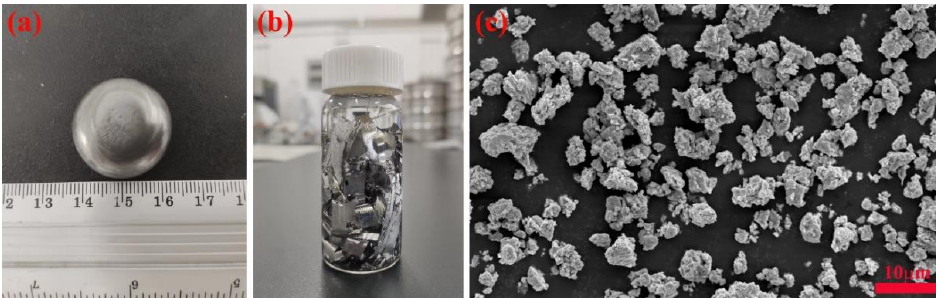
Figure 1. ( a ) Particle size distribution and ( b ) microscopic morphology of Sm 2 Fe 17 N 3 fine powder. Table 1. Oxygen content (ppm) summary of Ce 72 Cu 28-x Al x alloy strip and powders after ball milling.